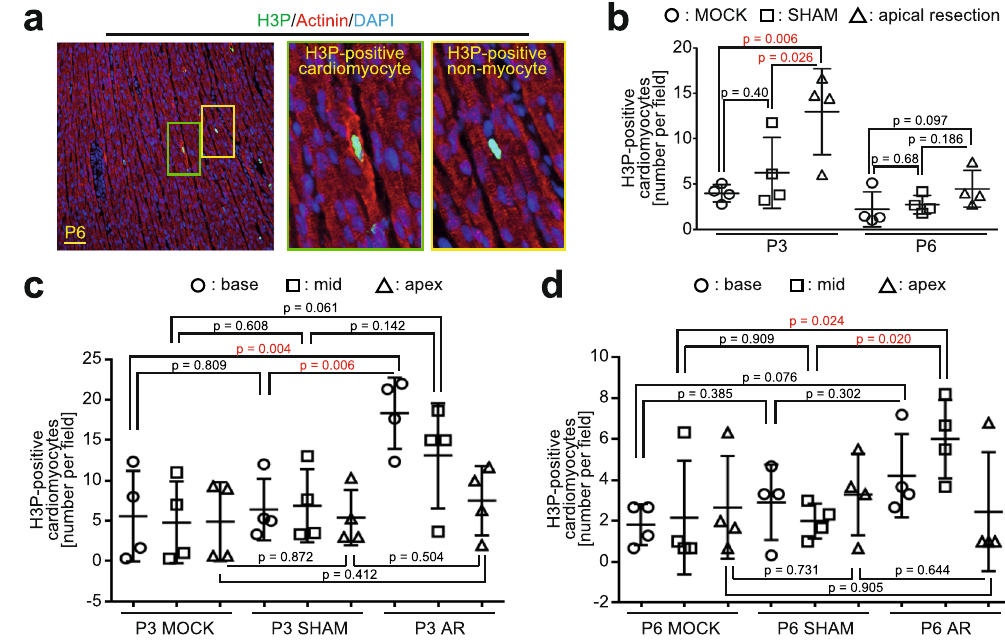
Figure 3. Analysis of H3P-positive cardiomyocytes in AR rat hearts. ( a ) Representative immunofluorescence images of a P6 H3P-positive cardiomyocyte and non-myocyte (scale bar: 50 µ m). Red: cardiomyocytes (sarcomeric- α -actinin); green: cells in mitosis (H3P); blue: nuclei (DAPI). Scale bar: 50 µ m (see also Supplementary Fig. 3). ( b ) Quantification of cardiomyocytes in mitosis at P3 and P6 based on anti-H3P and anti-sarcomeric- α -actinin staining. Nuclei were counterstained with DAPI. Data are ± SD. n = 4 for MOCK, AR, and SHAM at each time point. ( c , d ) Quantification of H3P-positive cardiomyocytes at P3 ( c ) and P6 ( d ) in apical, mid, and base zones. Data are ± SD. n = 4 for MOCK, AR, and SHAM at each time point. p-values have been calculated using Fisher’s LSD test after one-way